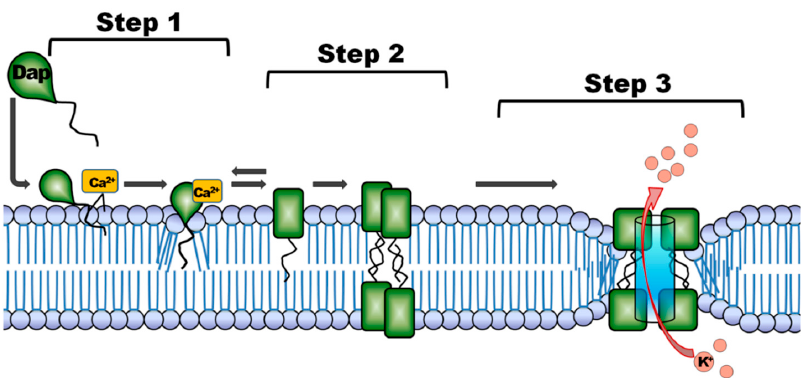
Figure 1. Potential antimicrobial mechanism suggested for depsipeptides. The postulated mechanism for daptomycin (Dap) is adapted from Steenbergen et al., 2005 [24]: step 1: binding to the cytoplasmic membrane; step 2: oligomerization and membrane disorientation, and step 3: release of intracellular ions followed by cell death.